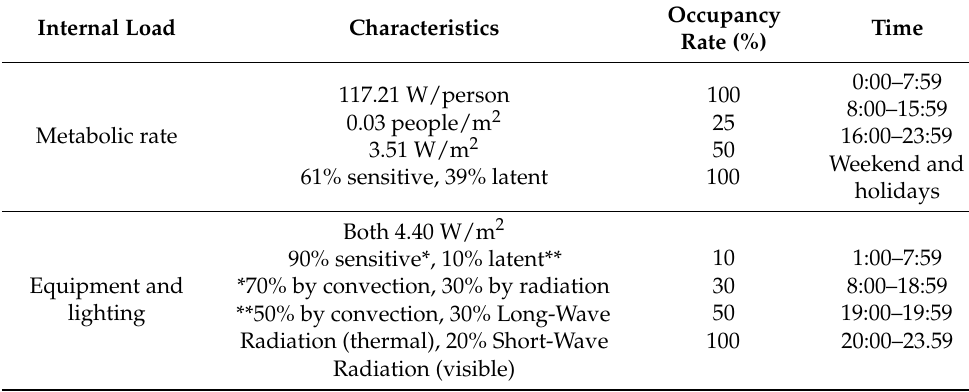
Table A3. Internal loads to estimate the building